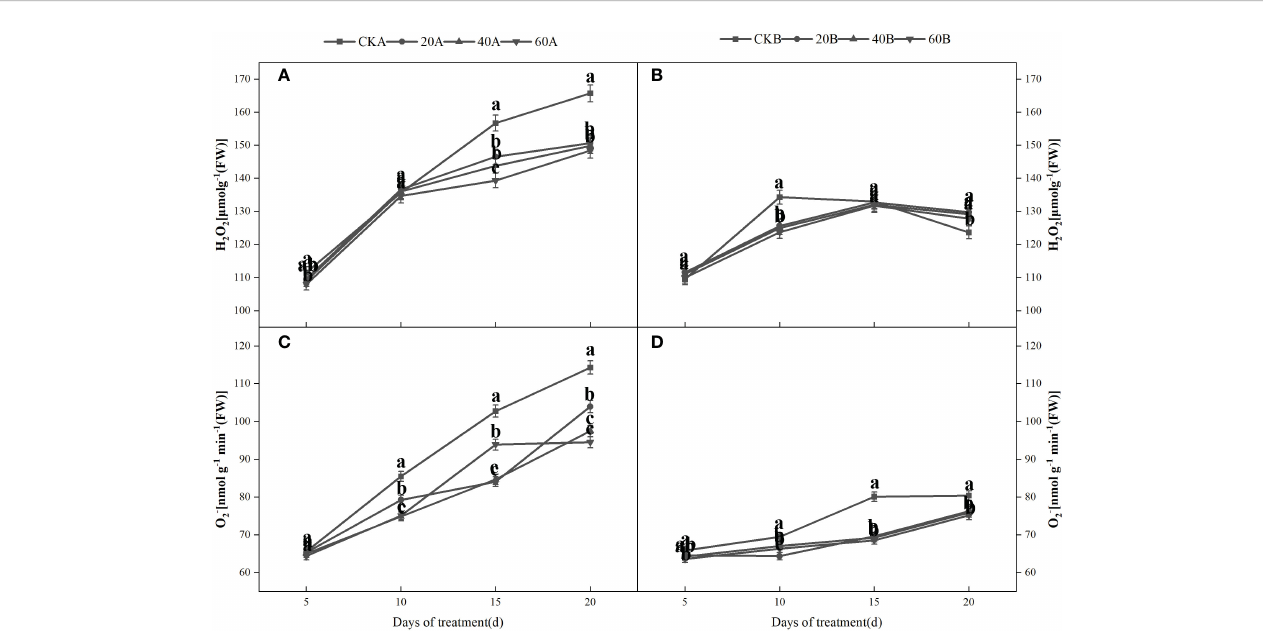
FIGURE 5 Effects of GA 3 on H 2 O 2 contents and O – 2 production rate in light-sensitive inbred maize lines after different periods under low light stress. In the fi gure panels, 20A, 40A, and 60A denote SN98A sprayed with 20 mg L – 1 , 40 mg L – 1 , and 60 mg L – 1 GA 3 , respectively, and 20B, 40B, and 60B denote SN98B sprayed with 20 mg L – 1 , 40 mg L – 1 , and 60 mg L – 1 GA 3 . CKA denotes the SN98A control group sprayed with water and CKB denotes the SN98B control group sprayed with water. In the fi gure, (A , C) represent the changes of H 2 O 2 and O – 2 after SN98A is treated with GA 3 . (B , D) are the changes of H 2 O 2 and O – 2 after SN98B is treated with GA 3 . Values are expressed as mean ± SD of three replicates. Lower-case letters indicate the mean difference of different treatments in the same period, which is statistically signi fi cant (P<0.05).